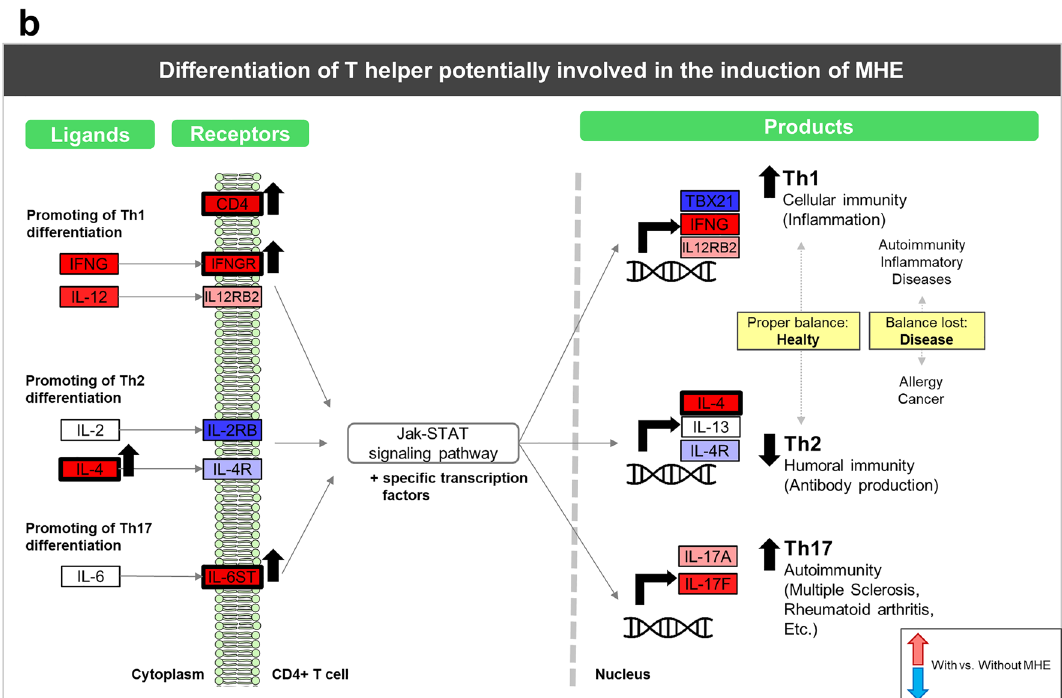
regulation of immunity 39 and the “Th17 cell differentiation” pathway showed a significant up-regulation of the IL6ST receptor and an increase in IL17A and IL17F expression that suggested the promotion of Th17 cell type in